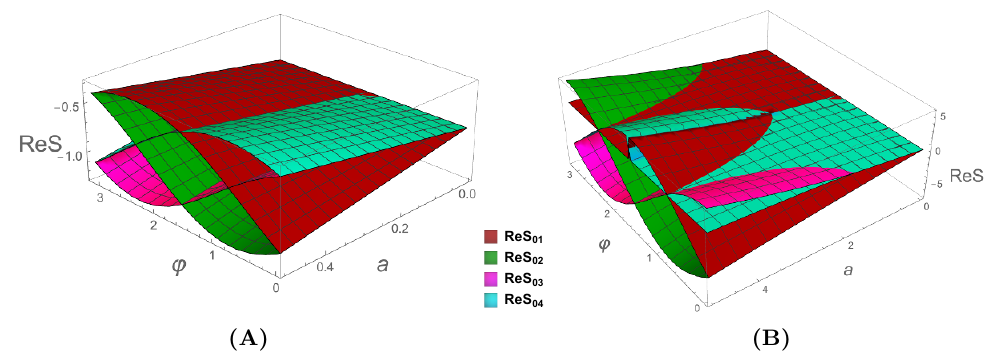
Figure 4 . ( A ) 3D plots for functions ReS 0 ; 1 ( a e i’ ) (red), ReS 0 ; 2 ( a e i’ ) (green), ReS 0 ; 3 ( a e i’ ) (magenta) and ReS 0 ; 4 ( a e i’ ) (cyan) at J = 1, small a and 0 < ’ < (cid:25) show that the complex A = a e i’ removes the degeneracy of the real part of the action. ( B ) The same plot as on ( A ),